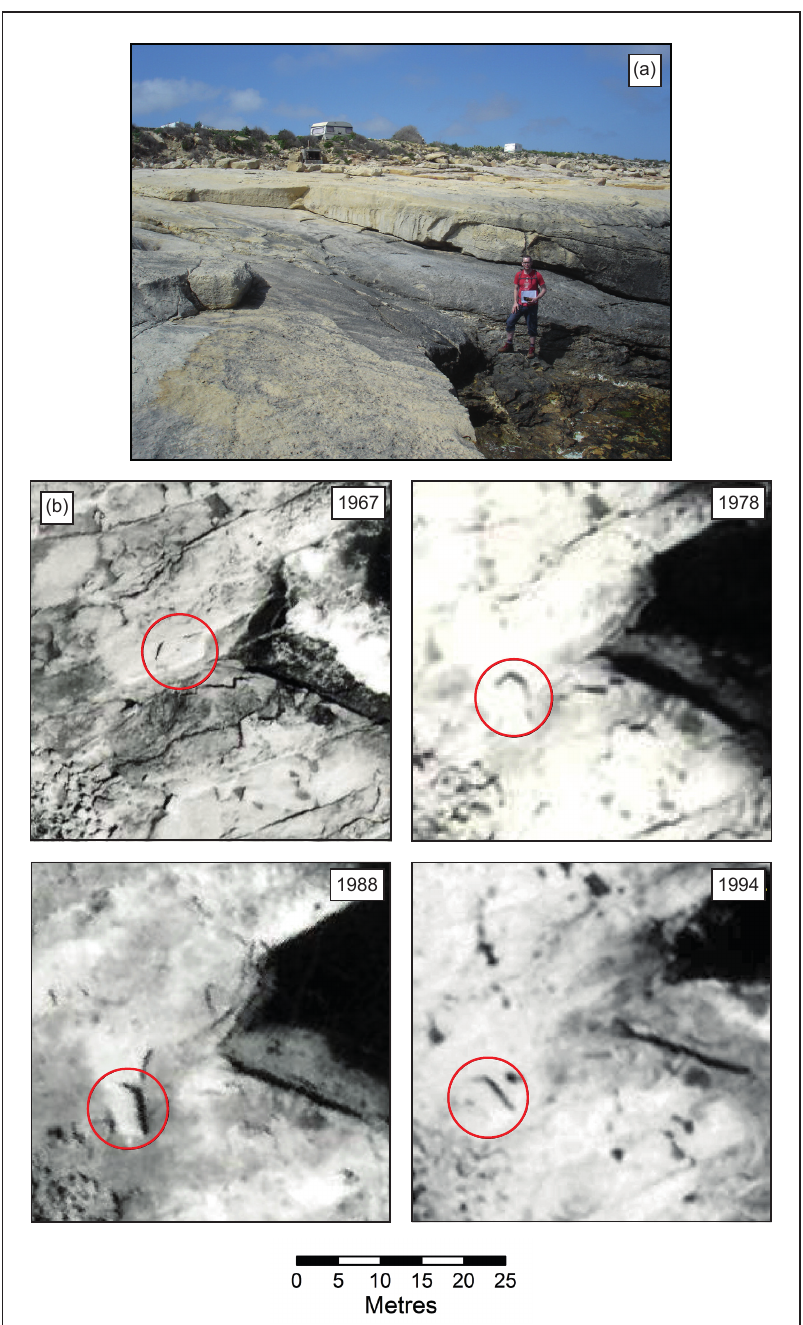
Figure 9. Transport history of recent mover boulder RM1: ( a ) the distinctive socket from which boulder RM1 was detached and the slipway up which it subsequently moved. The boulder now rests at the top of the slope just out of shot to the left; ( b ) the transport pathway taken by the boulder, showing three changes of position in the intervals o ff ered by the serial aerial